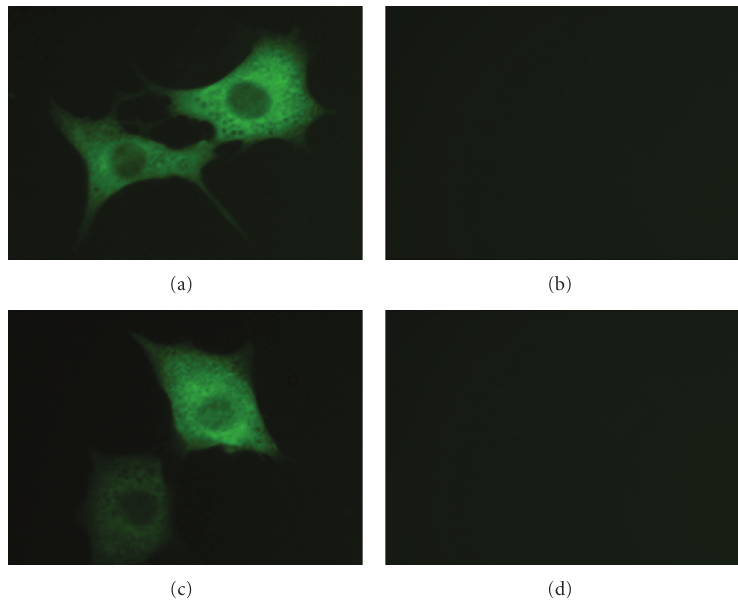
Figure 3: GFP expression requires de novo transcription. (a) Cells treated with 200 nM TSA express GFP. (b) When transcription inhibitor actinomycin-D (0.5 µ g/mL) is added to LDR cells together with TSA, no GFP expression is observed. The same pattern is seen with 25nM depsipeptide, with and without actinomycin-D in (c) and (d), respectively.